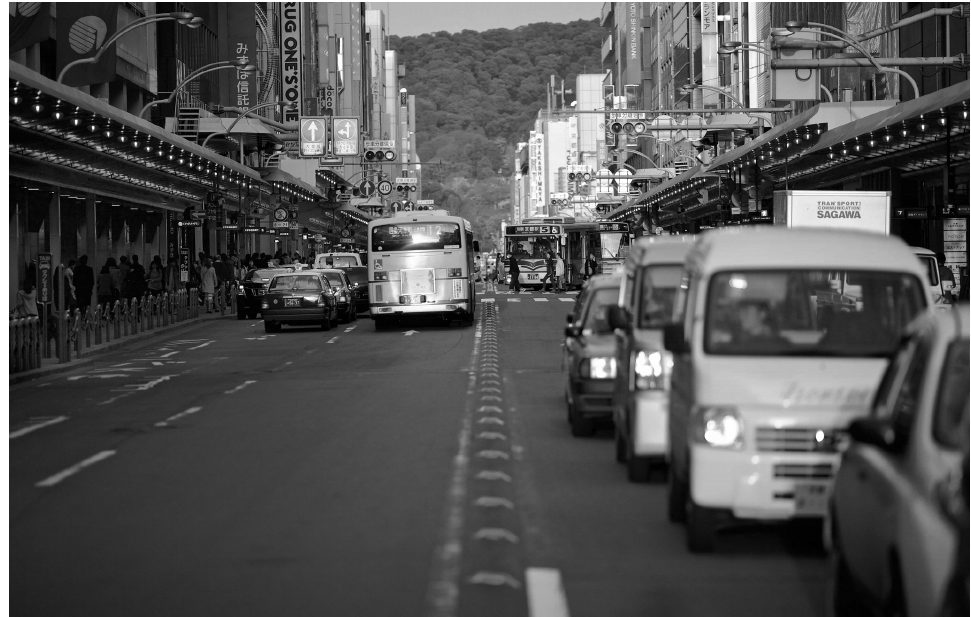
Figure A4. Decoded picture of traffic (8-bit, cropped to 2048 × 1320, and converted to gray) from the CLIC dataset using LOCO-ANS6 with NEAR = 3. bpp: 1.122. PSNR: 42.91